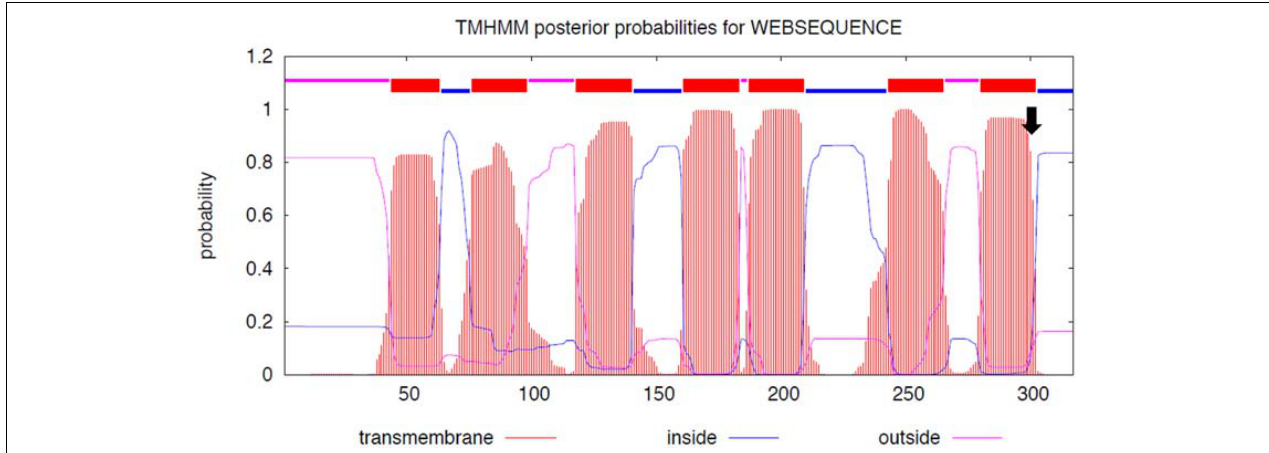
FIGURE 2 | MC1R protein functional domains. The seven MC1R transmembrane domains and the position of p.301R > C mutation (arrow); y -axis: the probability of the amino acid sequences to be cytoplasmic (blue), extracellular (magenta), or part of the transmembrane helix (orange); x -axis: amino acid sequence. We used Transmembrane Protein Topology with a Hidden Markov Model (Moller et al., 2001; http://www.cbs.dtu.dk/services/TMHMM/TMHMM2.0b.guide.php).